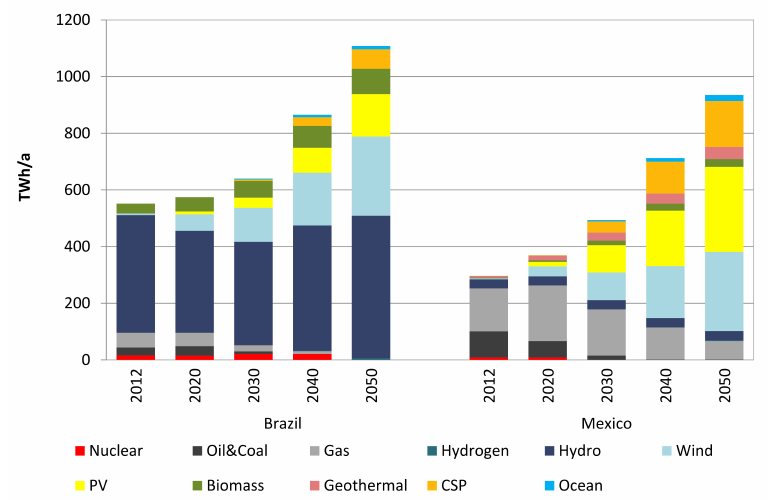
Figure 5. Power production from different sources in Brazil and Mexico in